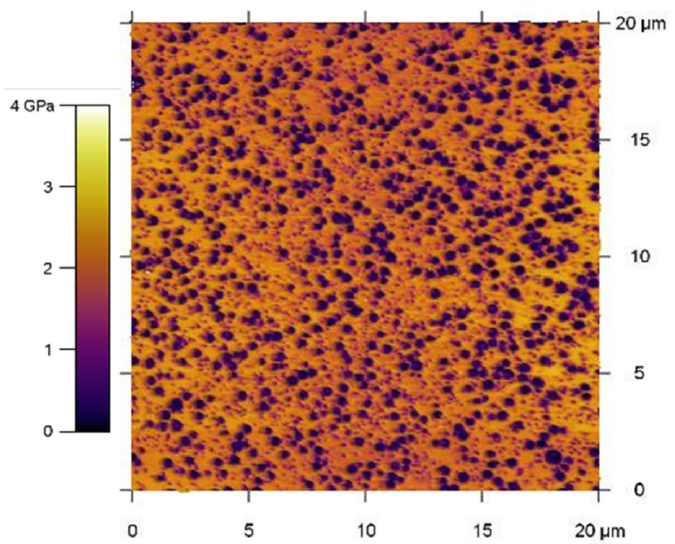
Figure 1. Nodular dispersion of PB within ABS—AFM picture produced by combination of topog- raphy and modulus cartography owing to AM-FM mode.